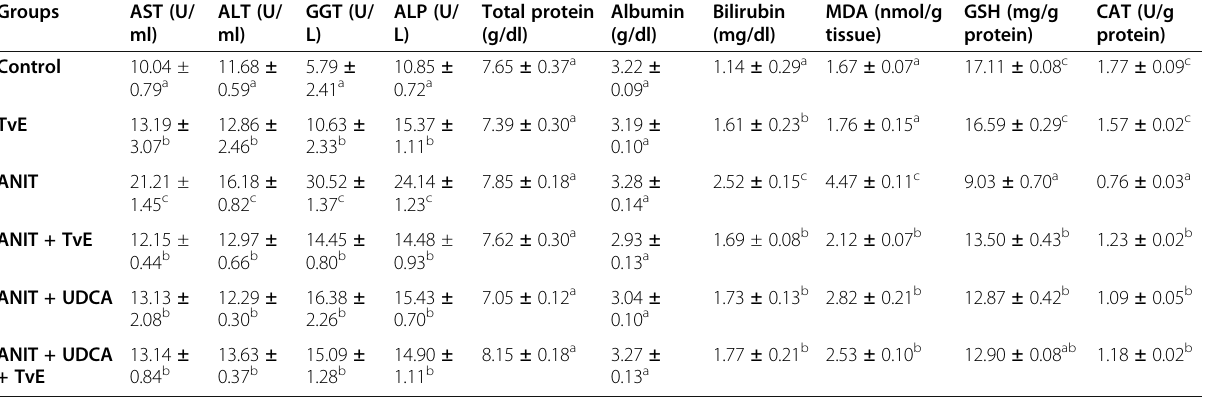
Table 1 Effect of Toxocara vitulorum extract (TvE) on biochemical parameters of cholestatic rats